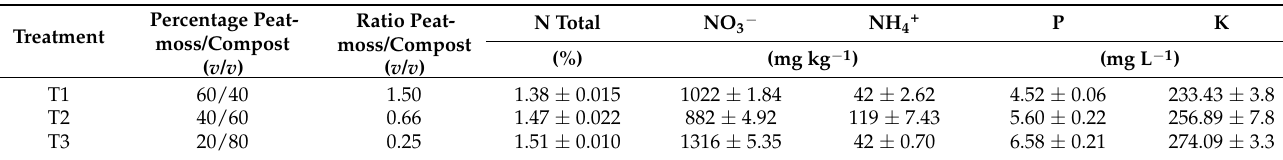
Table 1. Mineral composition of the substrate mixtures composed of peatmoss and compost at different percentages ( v / v ) used to grow lulo ( Solanum quitoense Lam.) seedlings.